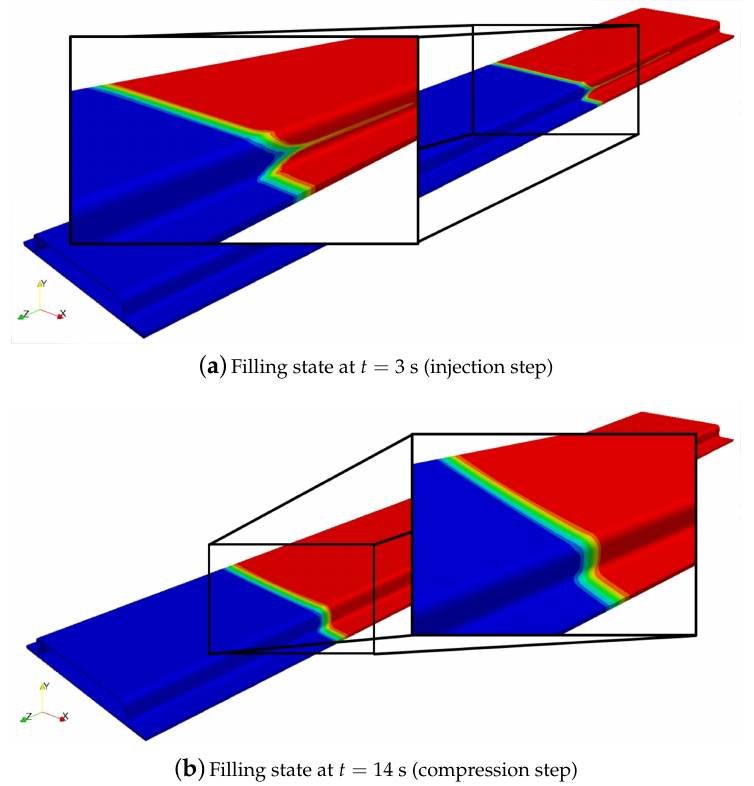
Figure 15. Filling state for two time steps of the simulation of the sandwich